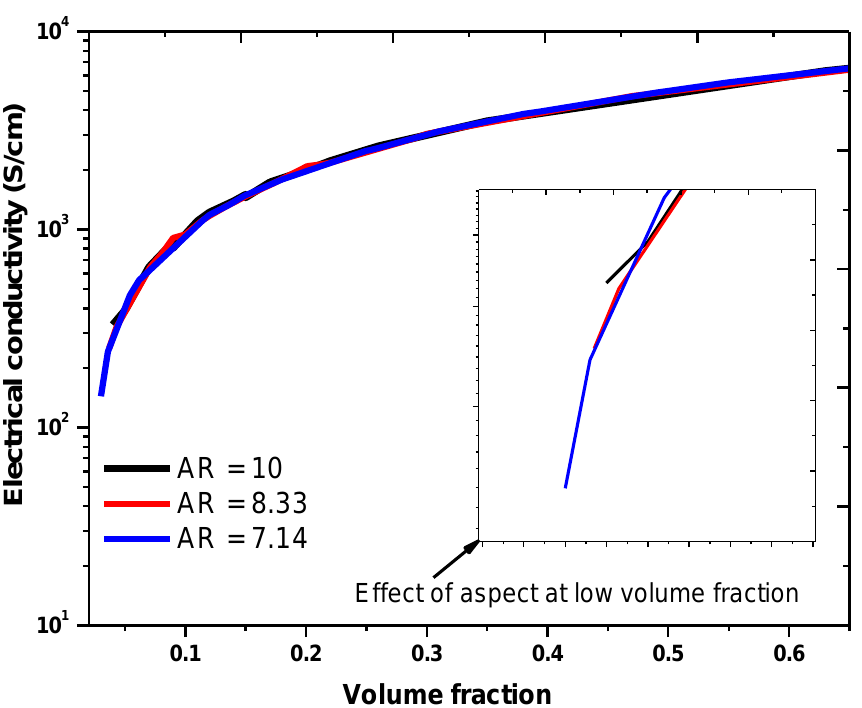
Figure 7. Electrical conductivity of the graphene–PPy composite at different aspect ratios. The effect of the graphene intrinsic conductivity was also investigated, as shown in Figure 8. The selected parameters were graphene length = 2 µ m , graphene diameter = 500 nm, matrix conductivity = 100 S/m, and insulation thickness = 0.9 nm. The effect of the intrinsic electrical conductivity of graphene was studied in the range of 10 4 − 10 7 S/m [50]. The composite electrical conductivity significantly increased with the graphene elec- trical conductivity. The increase in the effective conductivity of the composite with the increase in the filler conductivity is crucial for device applications, such as supercapaci- tors, sensors, batteries, and solar cells [40,51]. The calculation shows that the percolation threshold is independent on the filler conductivity. This result agrees with the literature results [40,46,52].